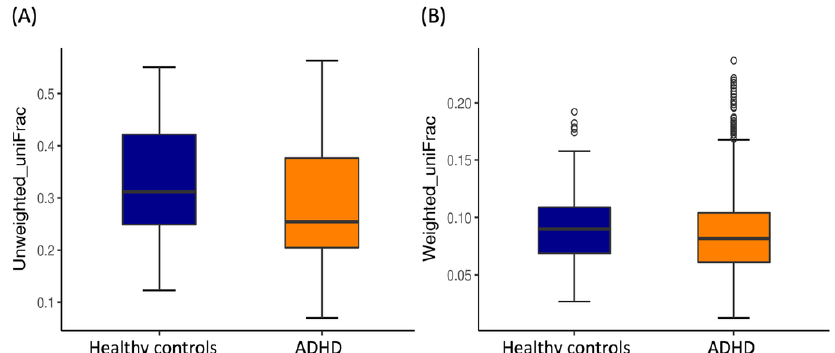
Figure 2. Beta diversity using unweighted and weighted uniFrac. Comparison of beta diversity measurements in ADHD children with treatment-naïve and healthy controls. Beta diversity, measured by unweighted ( A ) and weighted ( B ) unique fraction (UniFrac) is plotted for ADHD children with treatment-naïve (orange) and healthy controls (blue). The line inside the box represents the median, while the whiskers represent the lowest and highest values within the 1.5 interquartile range. Outliers as well as individual samples are shown as dots. The results indicated that there was significant difference in the gut microbiota communities between ADHD children with treatment-naïve and healthy controls.